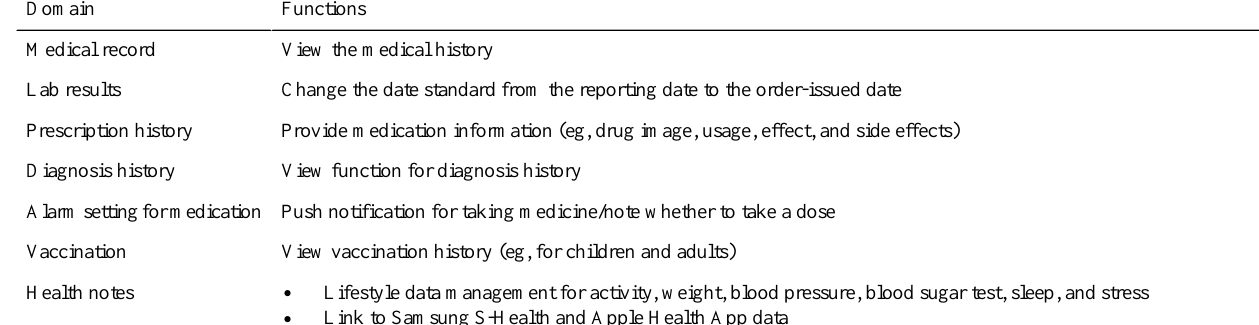
Table 1. Important functionalities identified by the task-force team.